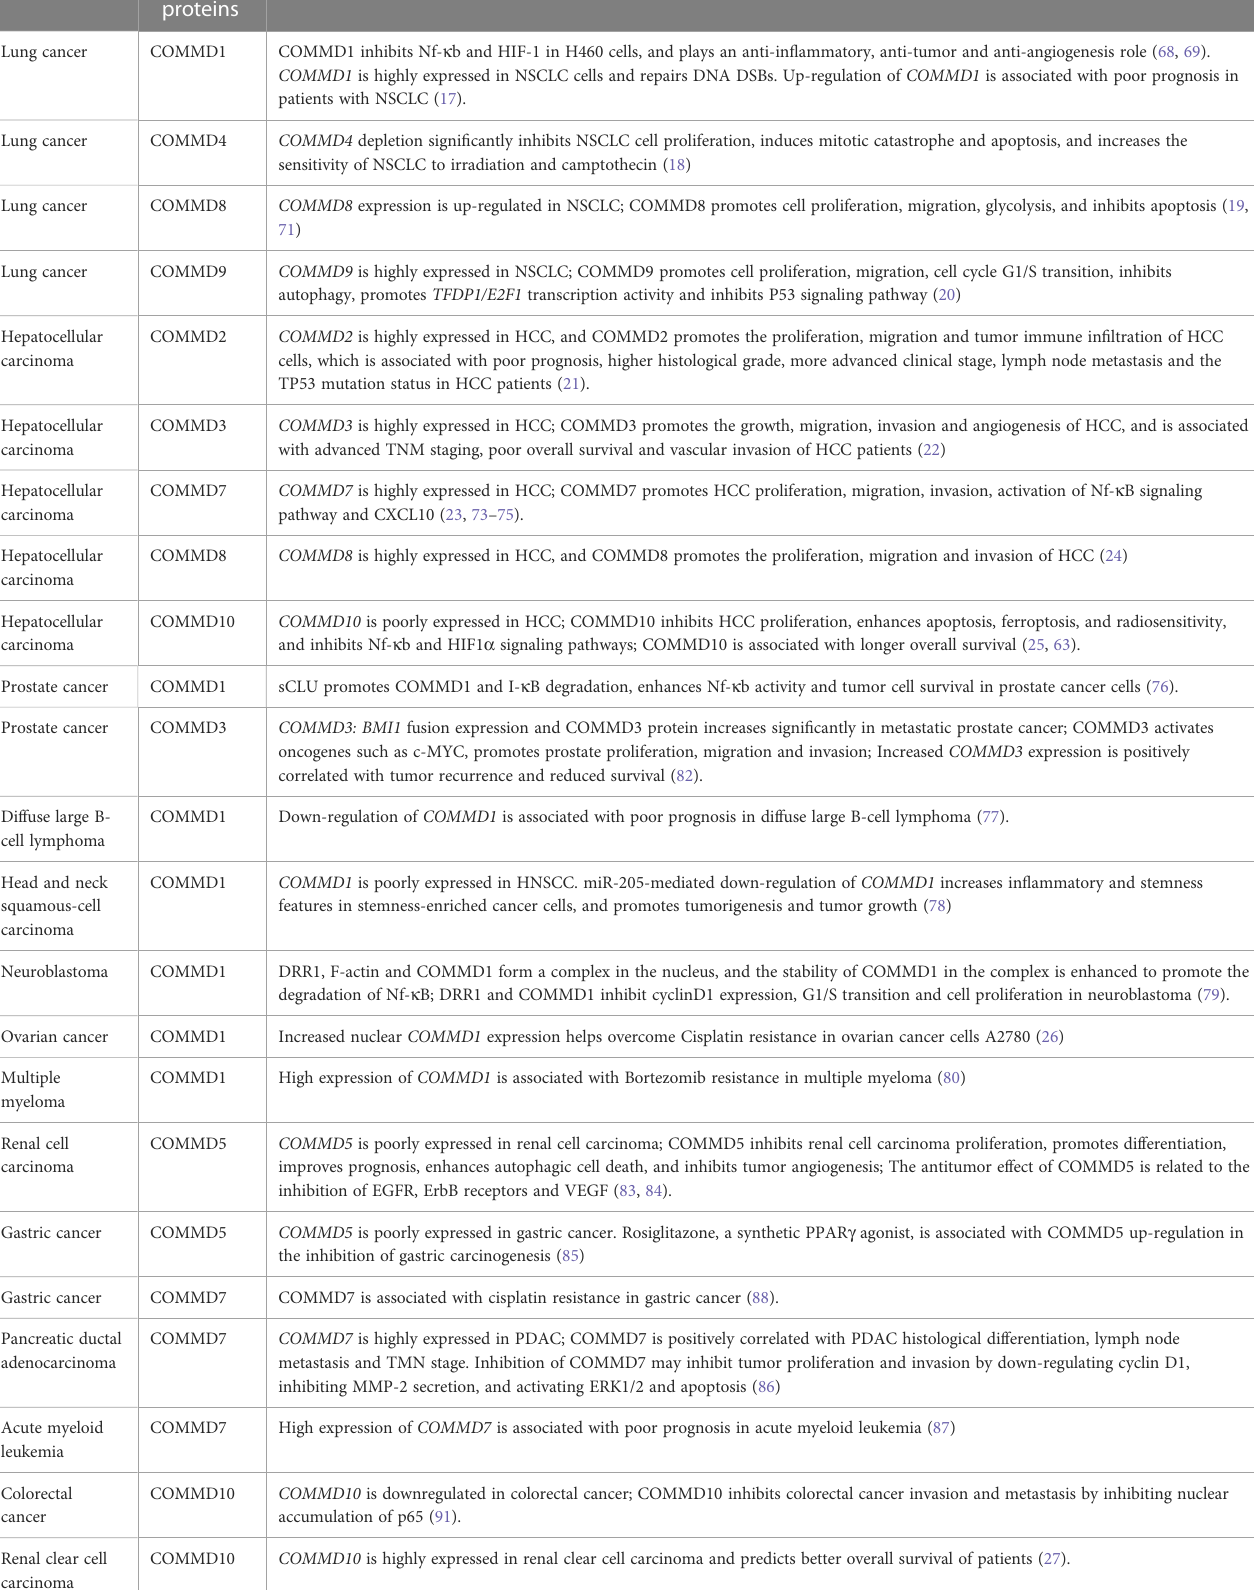
TABLE 1 The roles of COMMD proteins in different